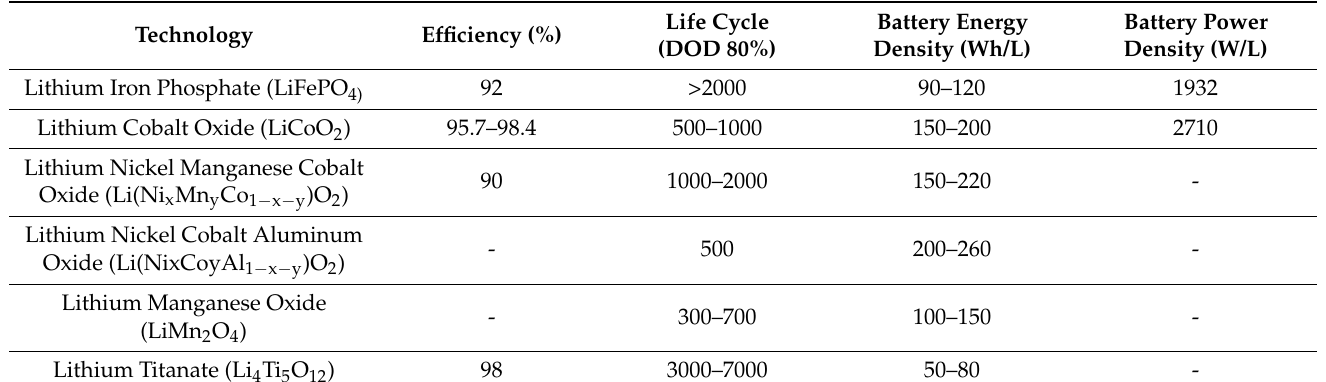
Table 7. Specification of technology lithium-ion batteries [70,71].